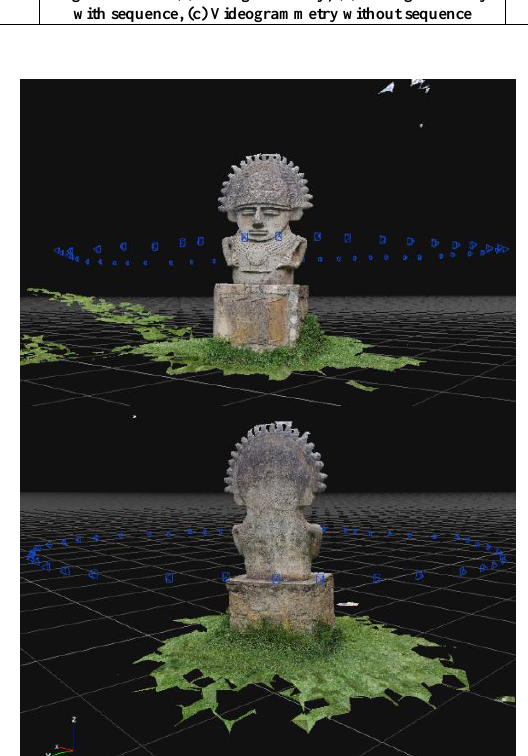
Figure 4. Dense point cloud. (a) Photogrammetry, (b) Videogrammetry with sequence, (c) Videogrammetry